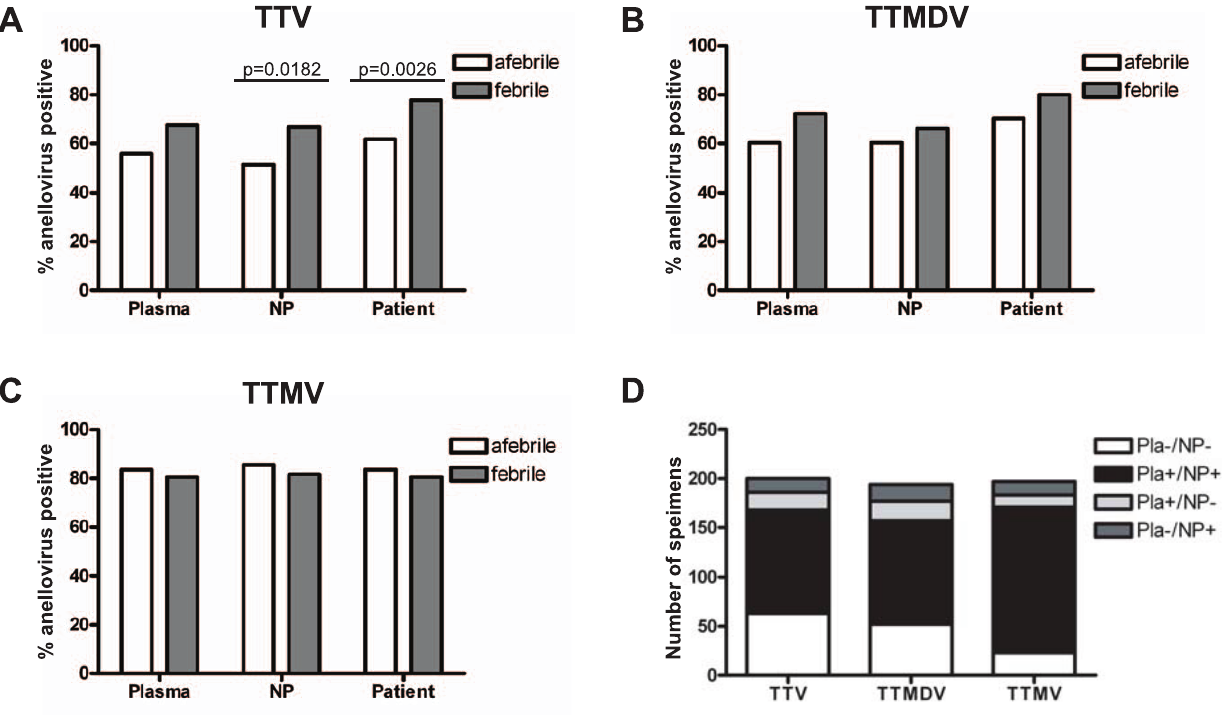
Figure 3. Many patient specimens contained DNA from multiple human anellovirus species. A–B . Patient plasma ( A ) and NP ( B ) specimens were assayed for TTV, TTMDV, and TTV DNA by PCR and the percentage of specimens with 3, 2, 1, or no anellovirus species were determined.